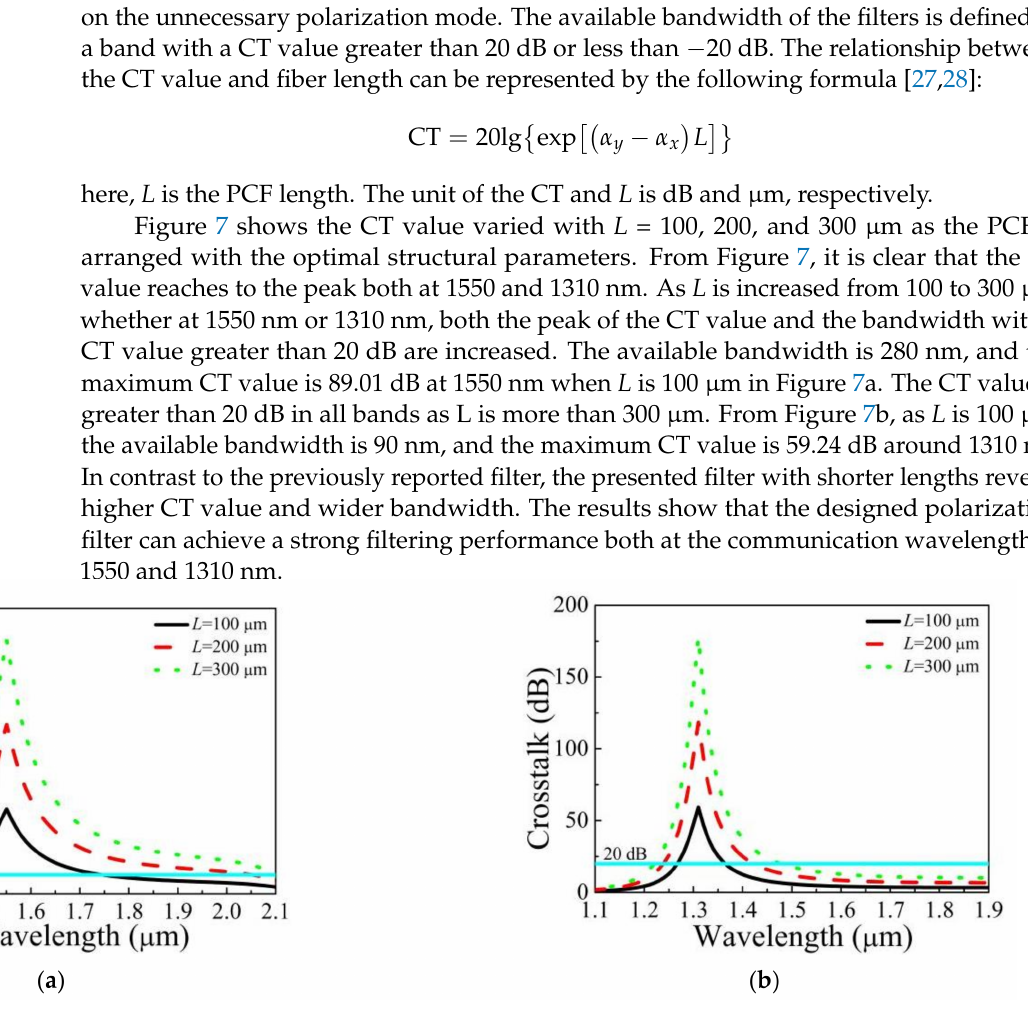
Figure 7. CT value varied with different L when d 1 = 2.40 µ m, d 2 = 1.38 µ m, d 3 = 1.80 µ m, d 4 = 2.20 µ m, ( a ) t = 25.60 nm and ( b ) t = 55.30